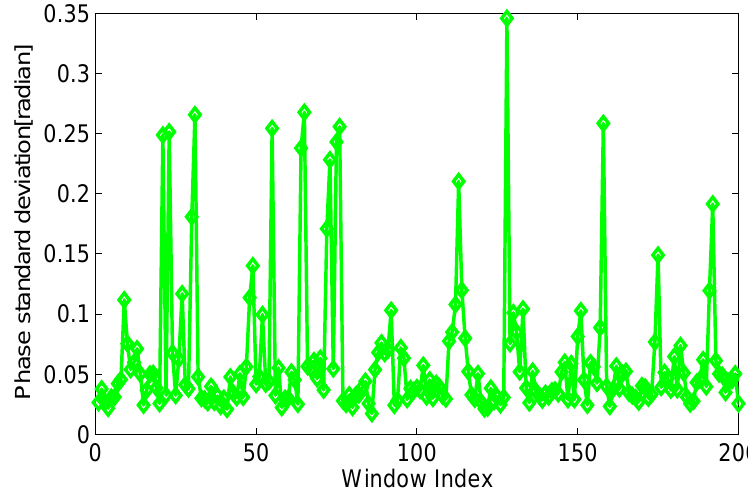
Figure 8. Phase variance of time windows in the dynamic